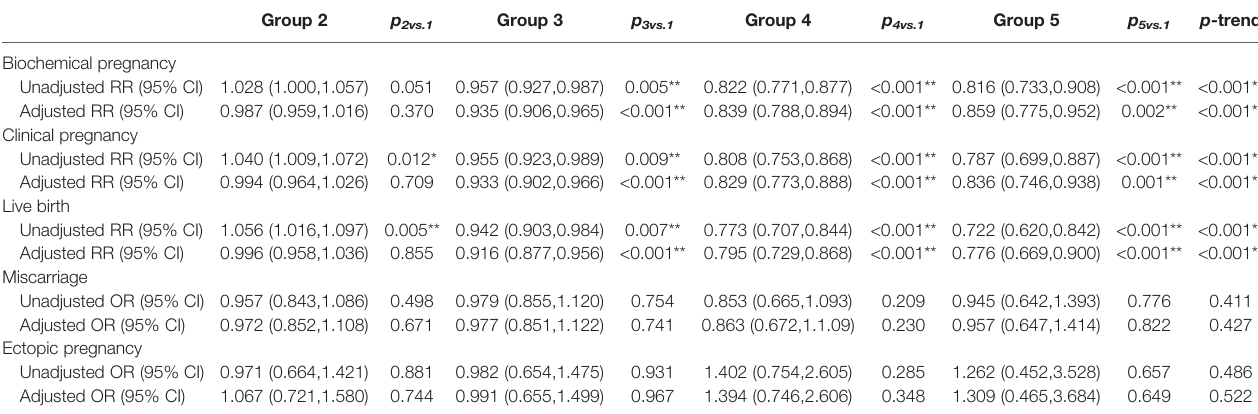
TABLE 2 | Associations between cryopreservation time and pregnancy outcomes.